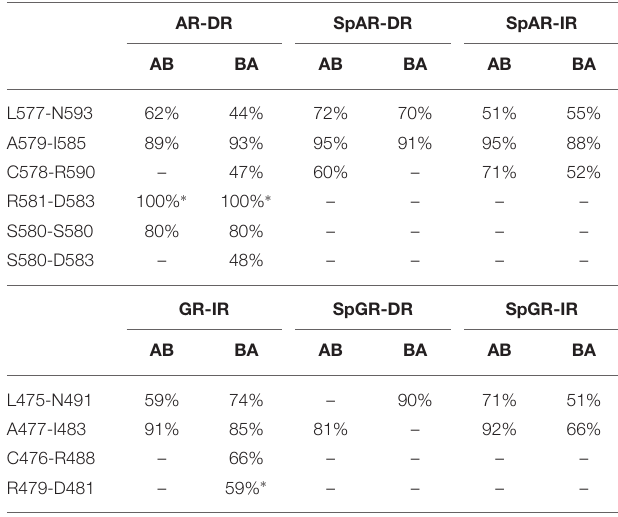
TABLE 1 | Protein-protein hydrogen-bond